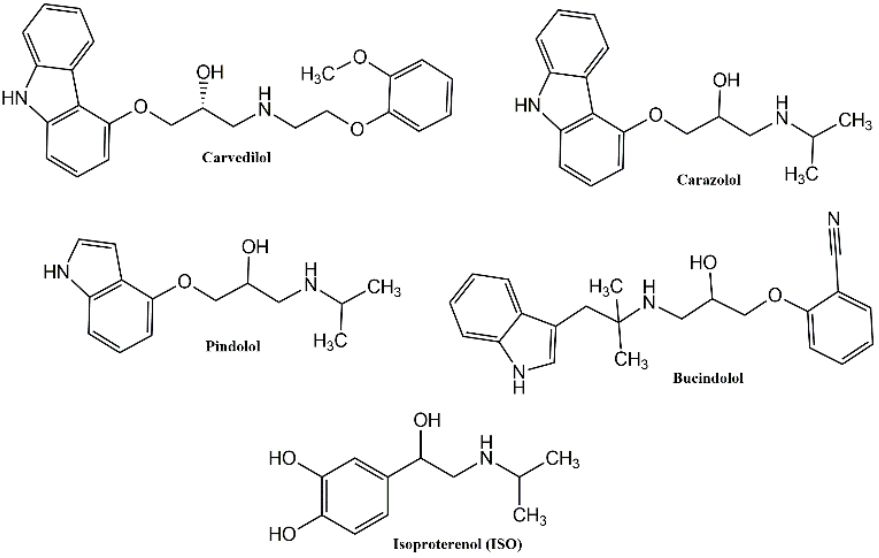
Figure 1. Representative structures of known β -blockers.